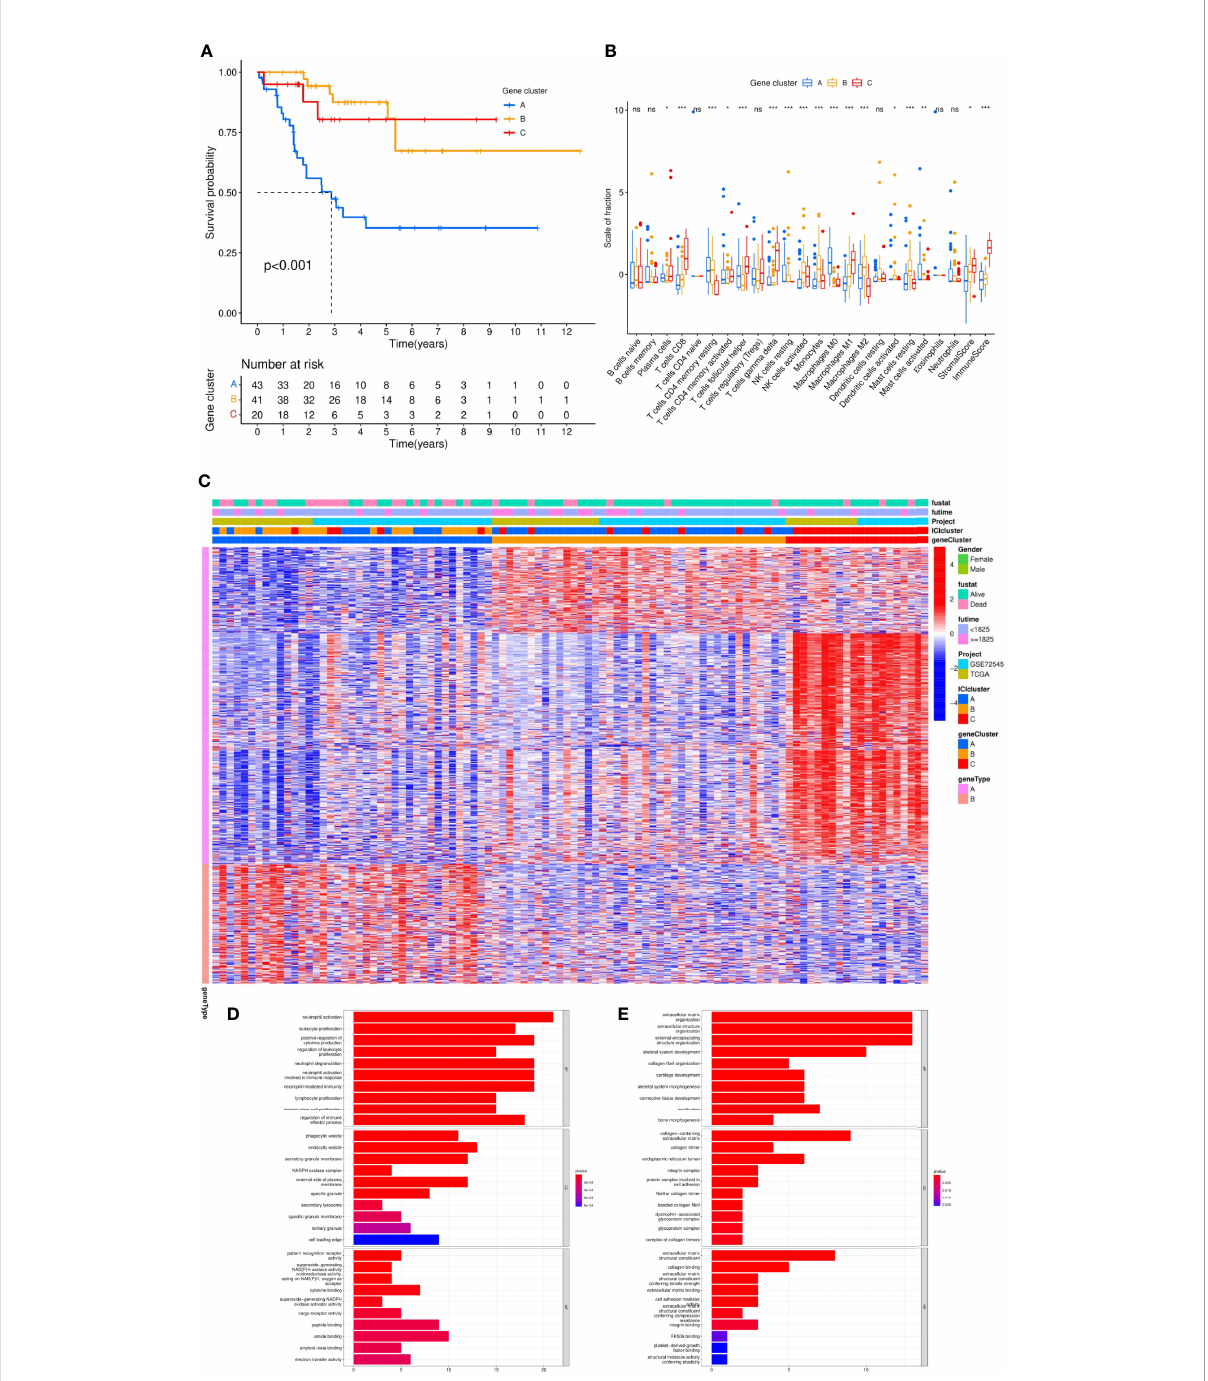
FIGURE 5 Differential analysis of genotyping of immune in fi ltration. (A) After unsupervised cluster analysis of DEGs and samples, we divided the samples into three independent gene clusters, the overall survival (OS) was analyzed by Kaplan – Meier analysis, and the log-rank test showed that P <0.001. (B) The differences in expression among 24 kinds of immune in fi ltrating characteristics in the 3 gene clusters were visualized in a box plot and statistically analyzed by Kruskal – Wallis test. (C) The clinical information was divided into two types. The abscissa was the samples, and the ordinate was the genes. (D, E) According to gene type A and gene type B, which were positively correlated with the ICI model in DEGs, the ordinate was the name of GO, the abscissa was the number of enriched genes, and the color represented the signi fi cance of the correlation (red indicated a positive correlation and blue indicated a negative correlation). ***p <0.001, **p <0.01, *p <0.05 and ns p>0.05,no signi fi